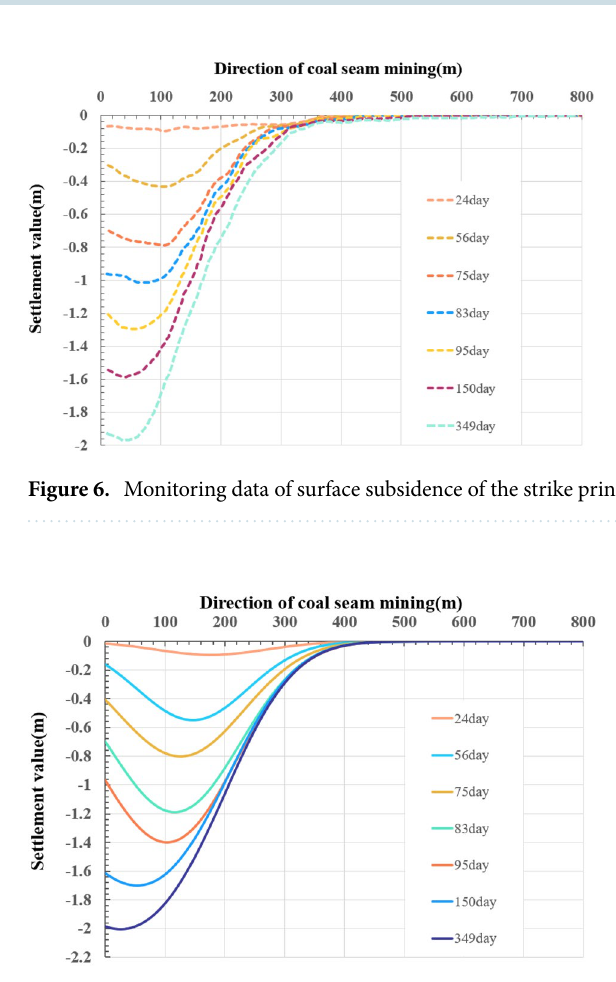
Figure 7. Prediction curve of surface subsidence of the strike principal